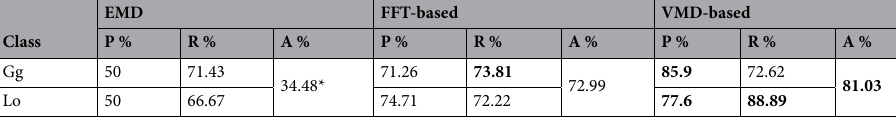
Table 1. Precision ( P ), recall ( R ), and total accuracy ( A ) of three classifiers for Gg and Lo: the EMD classifier 24 , the FFT-based features extractor classifier, and the VMD-based features extracted classifier. *Denotes accuracy for either Lo or Gg classifications